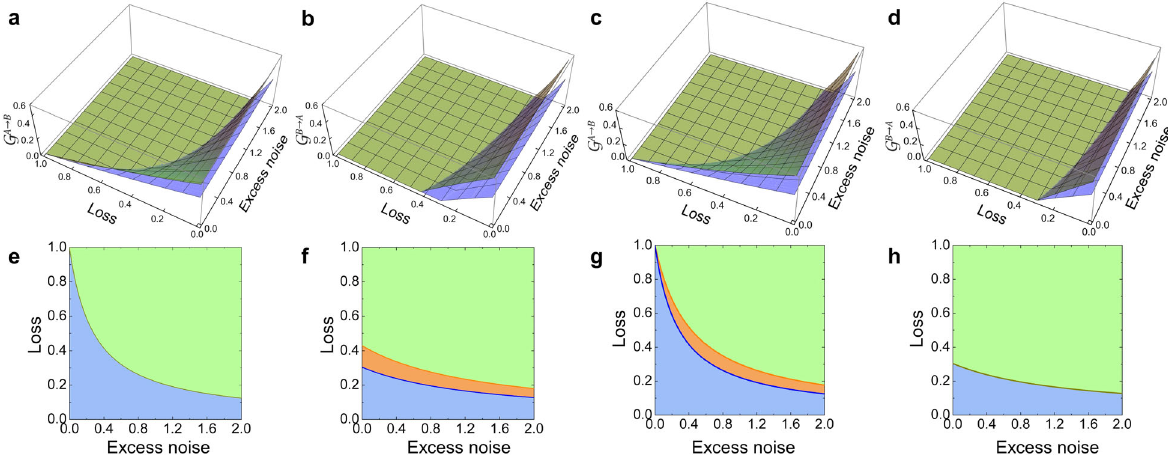
Fig. 4 Results for the distillation of Gaussian EPR steering with different excess noise levels. The steerabilities of G A ! B a and G B ! A b parameterized by loss and excess noise with (green) and without (blue) the NLA based on Bob ’ s measurement results with gain g = 1.2, respectively. The steerabilities of G A ! B c and G B ! A d parameterized by loss and excess noise with (green) and without (blue) the NLA based on Alice ’ s measurement results with gain g = 1.2, respectively. e – h are the EPR steerable regions parameterized by loss and excess noise, which are obtained from the projections of a – d , respectively. Green region: nonsteerable region; Blue region: the steerable region before NLA; Orange region: the steerable region extended after the NLA.